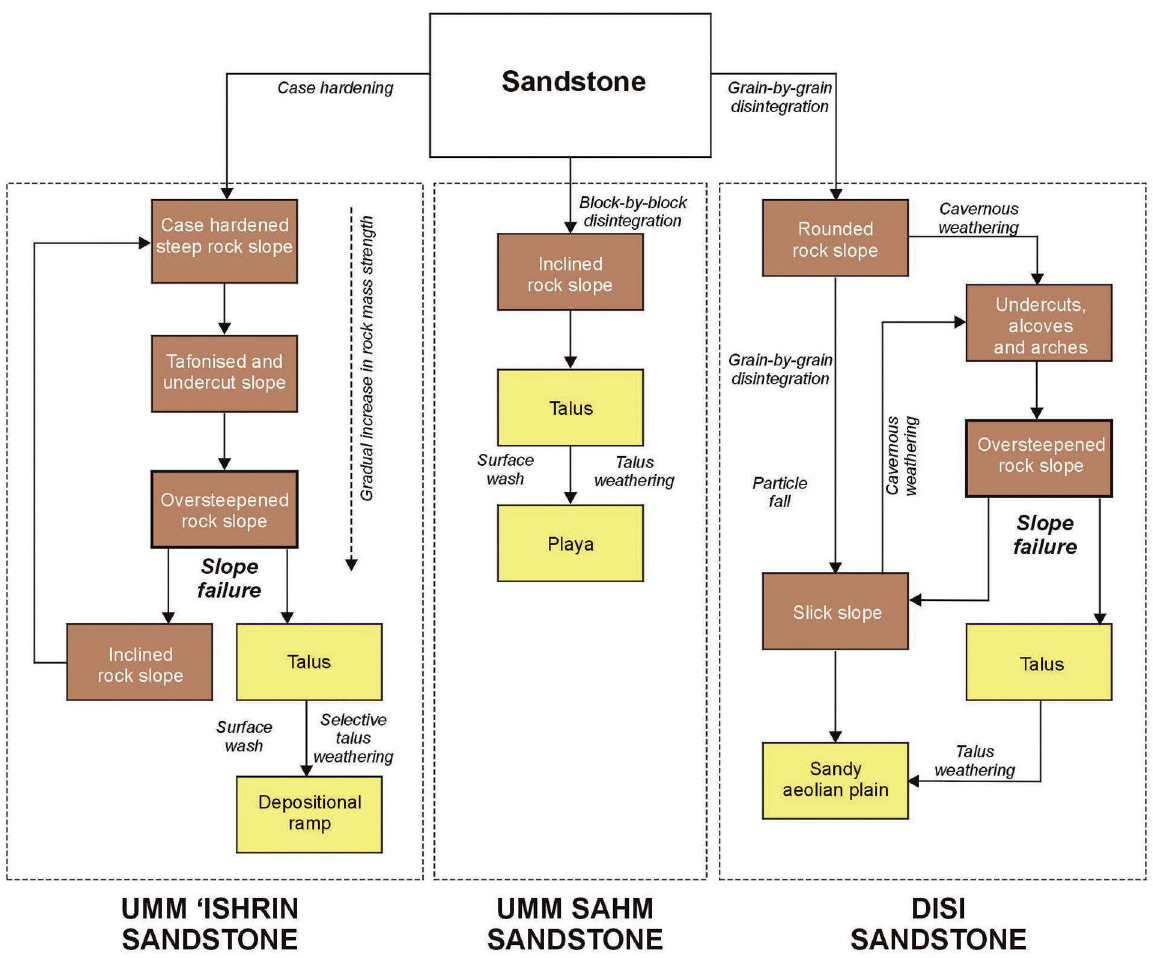
Fig. 4. Different pathways of slope evolution in the three major sandstone units of south-west Jordan (modified from Migoń 2007)